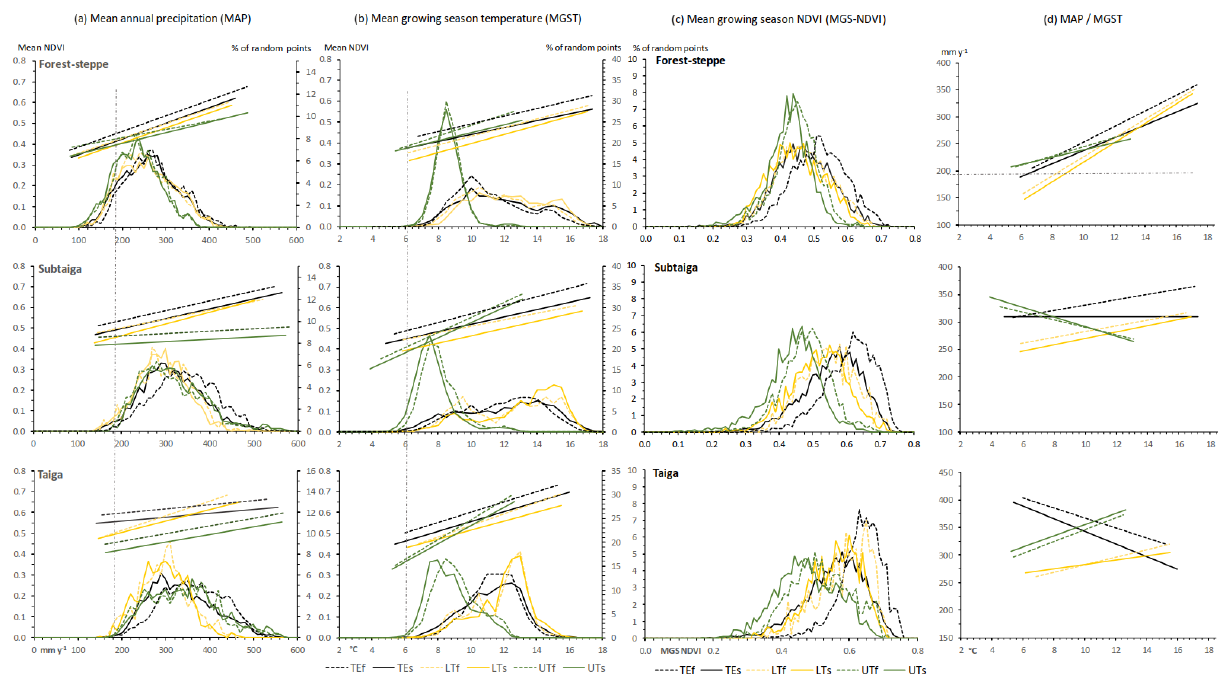
Figure 5. Mean annual precipitation (MAP) and mean air temperature during the growing season (MGST) related to the mean growing season NDVI of random points of different ecosystem units (values averaged for the investigation period 1999–2013). The straight lines represent the linear regressions between climate parameters and NDVI. The distribution curves represent the frequency of random points (%). Dashed lines represent forest values (f), continuous lines represent grassland values (s), yellow colors represent lower treeline values (LT), green color represents upper treeline values (UT) and black colors represent the total ecological unit values (TE). Vertical grey dashed lines indicate the deduced minimum values for tree